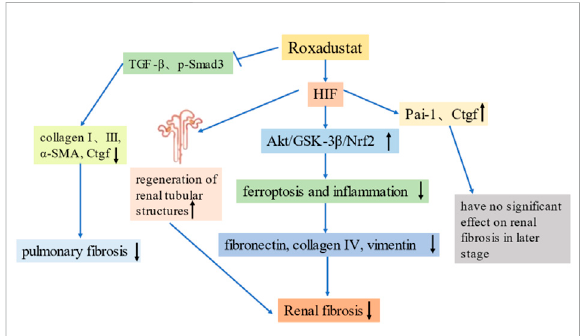
FIGURE 3 Roxadustat reduces fi brosis. Far-left: Roxadustat inhibits the expression of TGF- β and p-Smad3, and reduces the levels of collagen, α -SMA and Ctgf, thereby alleviating pulmonary fi brosis. Left: Roxadustat upregulates HIF, promotes the regeneration of renal tubular structures, and alleviates renal fi brosis. Middle: Roxadustat upregulates HIF, promotes the Akt/GSK-3 β / Nrf2 pathway, reduces ferroptosis and in fl ammation, and thereby reduces the production of fi brotic proteins and renal fi brosis. Right: Roxadustat upregulates HIF, which may upregulate the expression of pro- fi brotic genes (Pai-1 and Ctgf), but does not signi fi cantly promote renal fi brosis in the later stages of